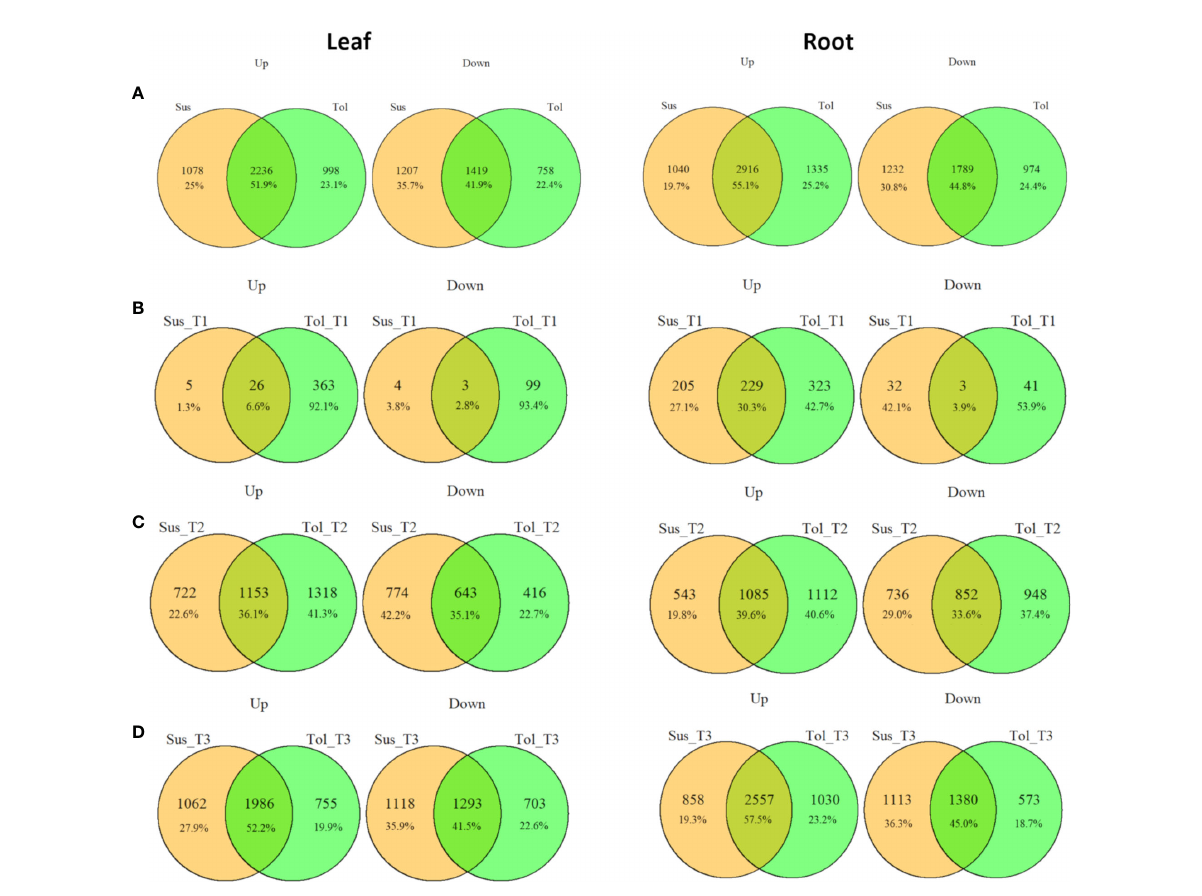
FIGURE 3 Commonalities and differences in drought-responsive DEGs between tolerant and susceptible varieties. Overlap between up- and down- regulated DEGs in leaf and root in tolerant (Tol) and susceptible (Sus) varieties in at least one drought-stressed time point (T1-T3) (A) , or in each of the early T1 (B) , late T2 (C) or recovery after rewatering T3 (D) time points compared with the non-stressed control